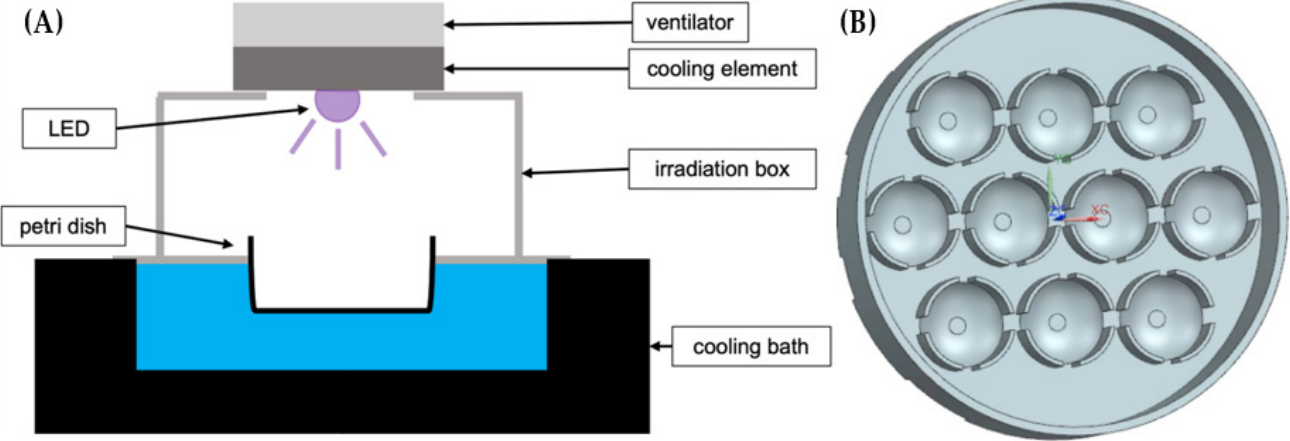
Figure 1. ( A ) Setup for irradiation of porcine lenses, consisting of a 3D-printed box, a cooling water bath and a LED-set with a ventilator and cooling element. ( B ) Custom-made Petri dish with ten holders for storing lenses during irradiation.